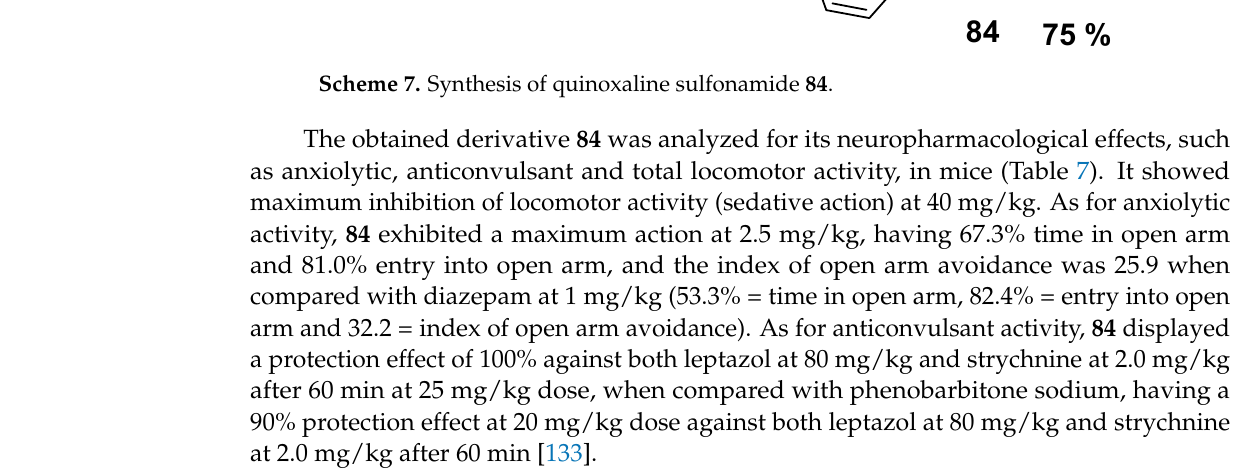
Table 7. Neuropharmacological activity of quinoxaline-based substituted benzene sulfonamide derivatives.